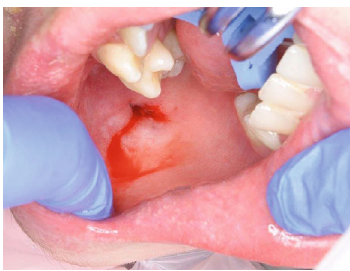
Figure 5: Case 2. Photograph about 15h after the accident. The margin of the left soft palate is